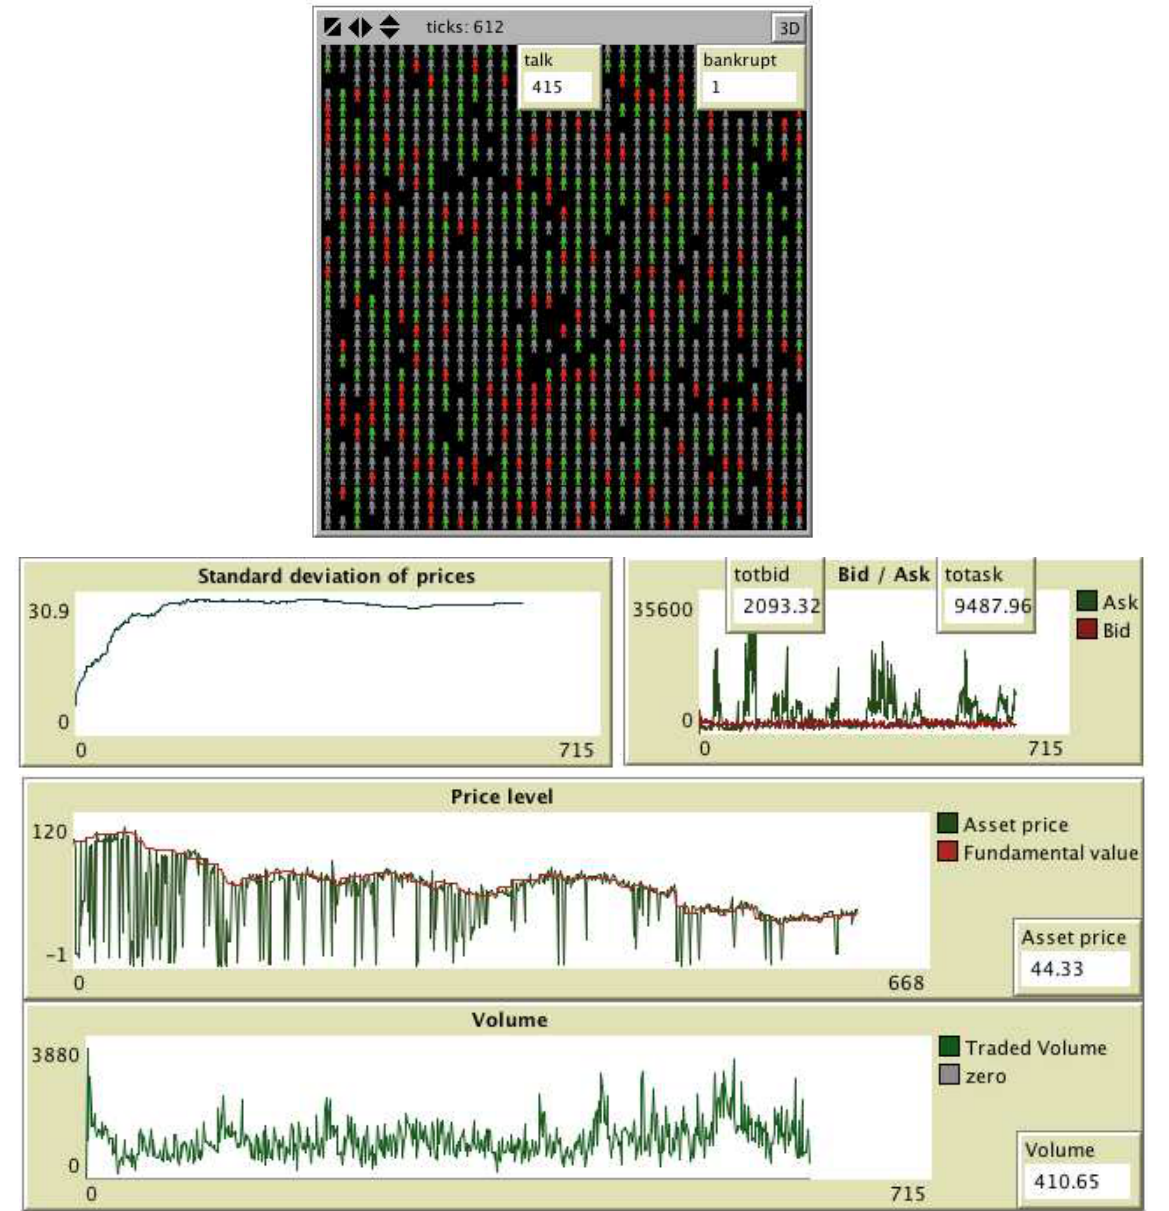
Figure 5. The evolution of stock market